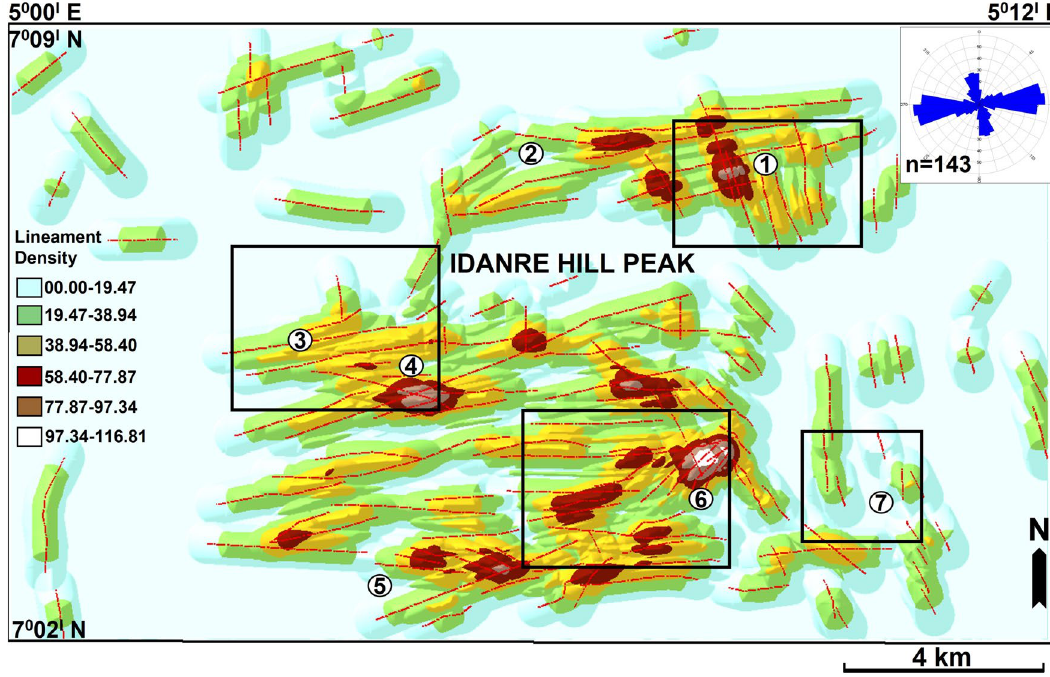
Figure 9. Lineament density (/km 2 ) map of the study area as derived from the digitized lineaments from the hillshade maps in Fig. 4. The rose diagram is used to demonstrate the strike of the